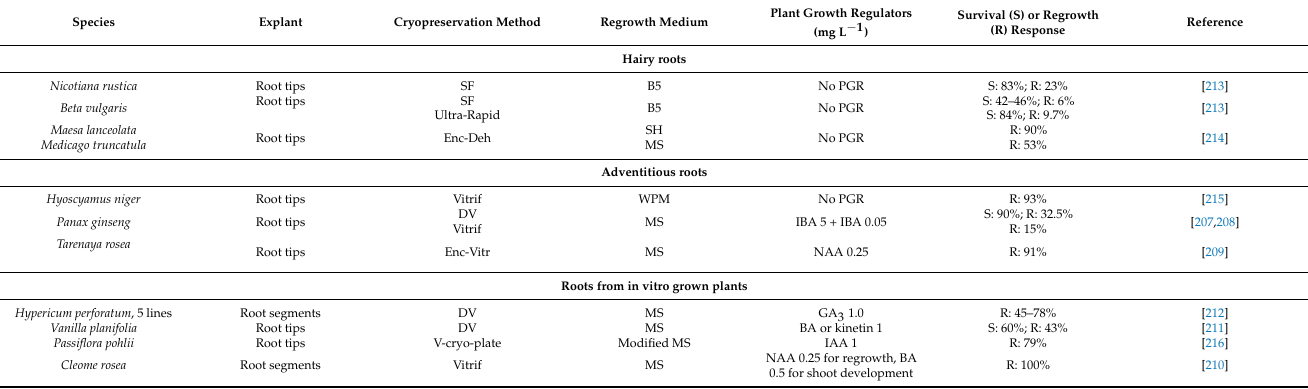
Table 5. Examples of plant growth regulators used at the recovery step during cryopreservation of root tips and